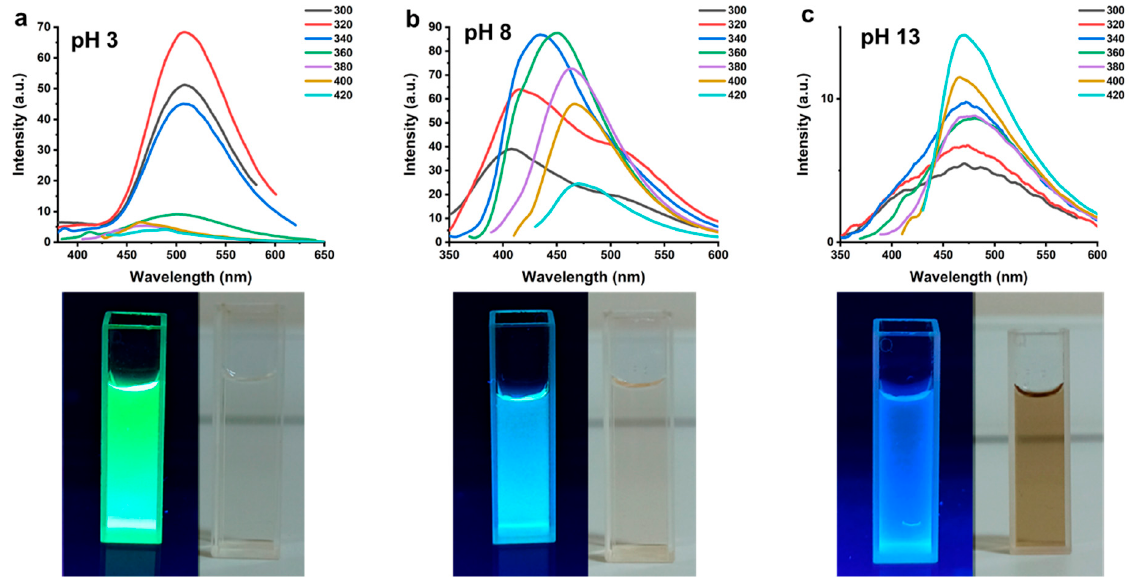
Figure 1. PL spectra of B/N-CQDs at pH values of 3 ( a ), 8 ( b ), and 13 ( c ) and their corresponding optical images under daylight and a 365-nm UV lamp.